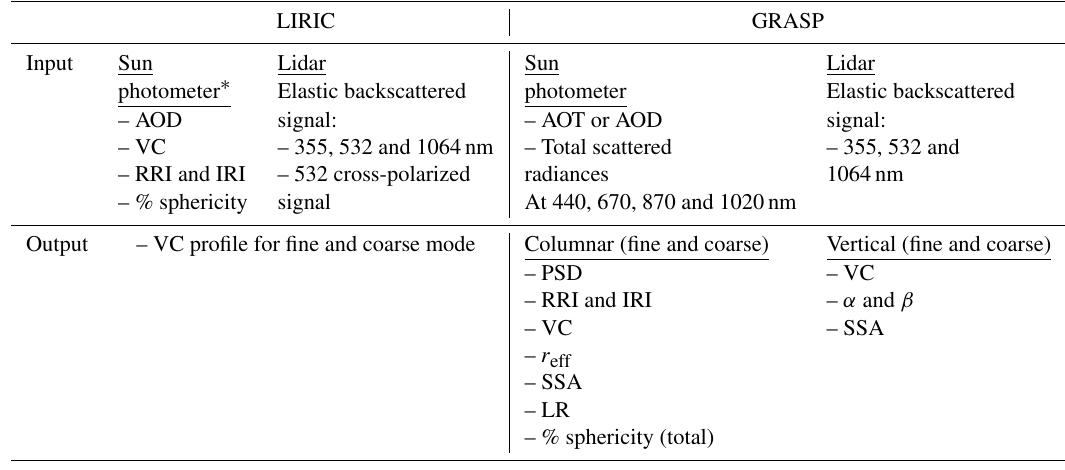
Table 2. Input and output information used for LIRIC and GRASP